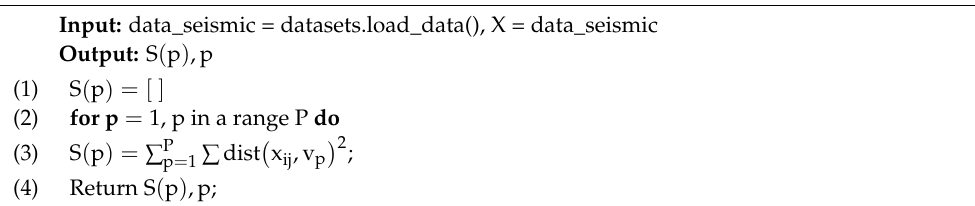
Algorithm 1. Pseudo code of